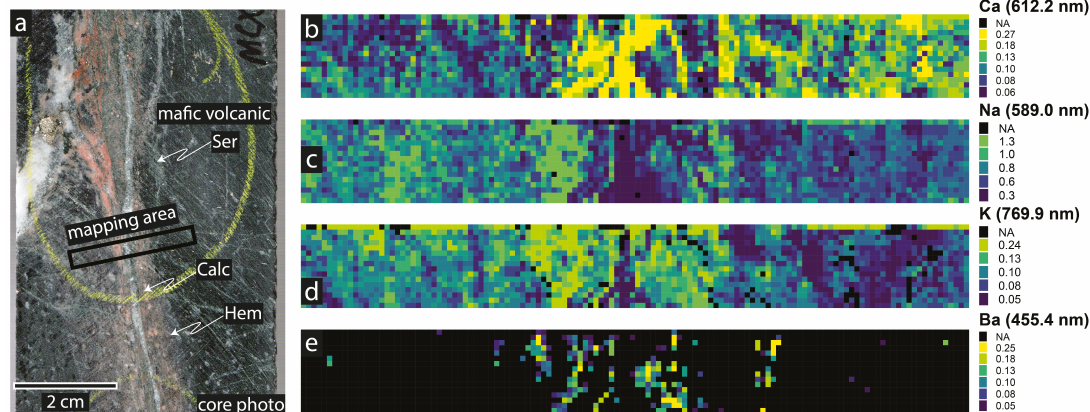
Figure 28. ( a ) Core photo of quartz (Qtz)–calcite (Calc) veinlet with sericite (Ser) and hematite (Hem) halo overprinting carbonate-altered mafic volcanic rock; LIBS mapping results for ( b ) Ca, ( c ) Na, ( d ) K, and ( e ) Ba processed using new R code and displayed as relative wavelength intensities (%). Maps highlight Na- and K-rich halo overprinting Ca-altered mafic volcanic host rock. The most K-rich veinlet domains are associated with Ba, reflecting minor element substitution within hydrothermal